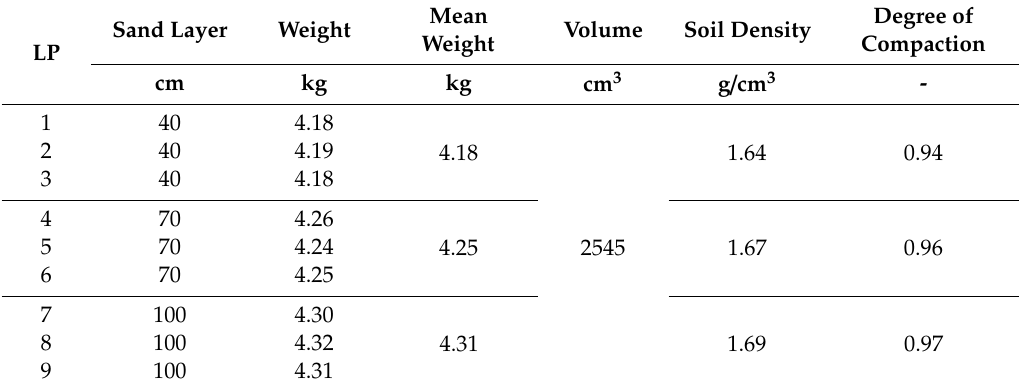
Table 3. Results of soil density tests with cylindrical